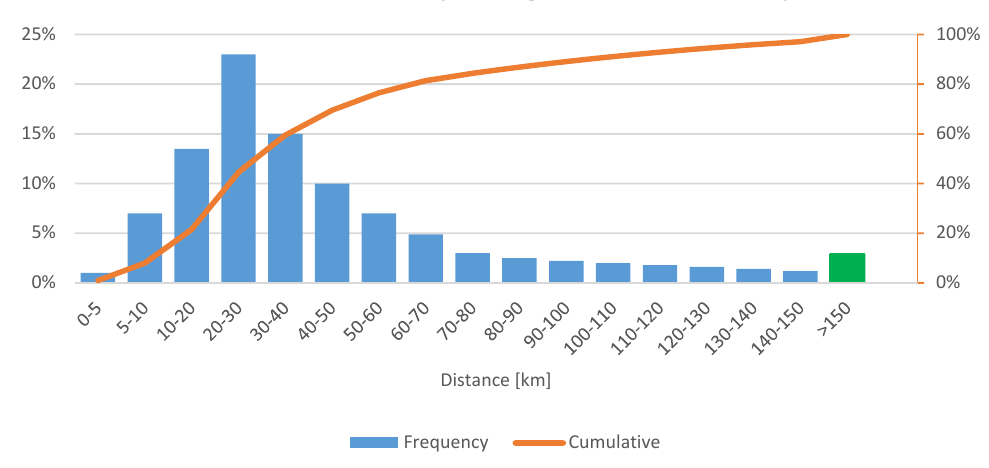
Figure 1. Example of an average daily driven distance distribution (based on Redelbach et al. [28]).